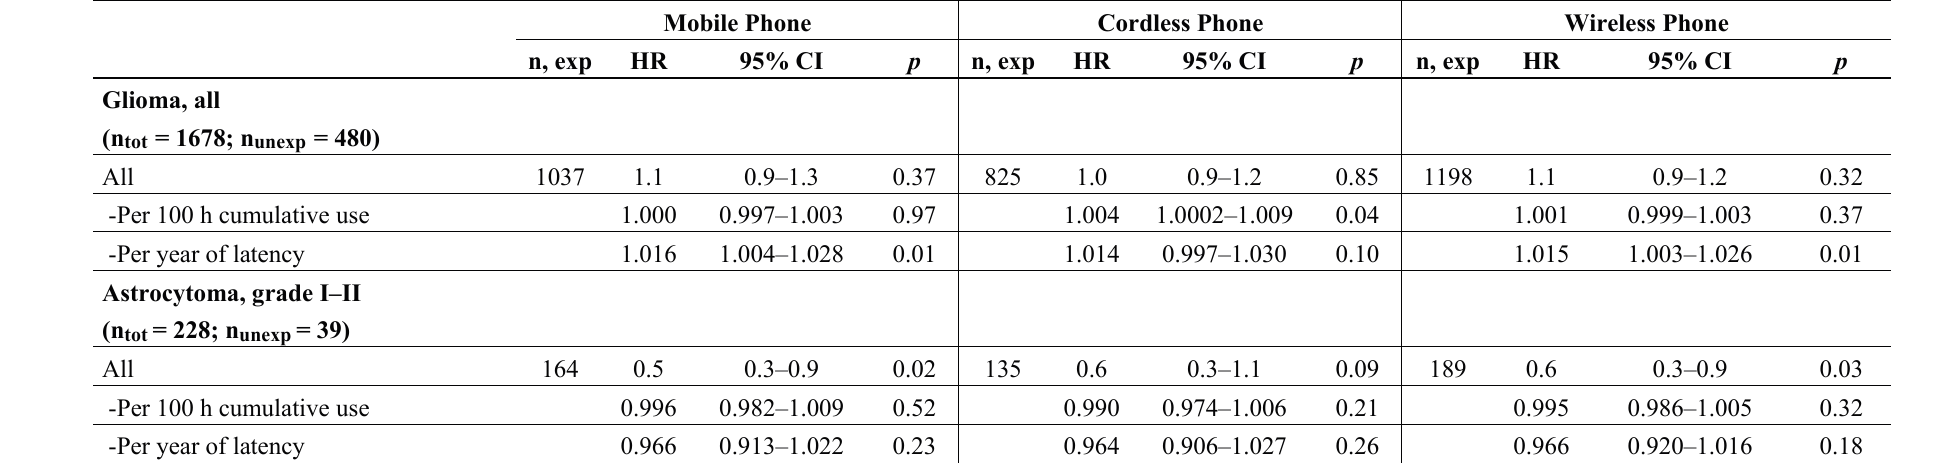
Table 2. Hazard ratio (HR) and 95% confidence interval (CI) from the Cox proportional hazards model for glioma and subtypes and use of mobile and cordless phones, overall results (ever use), per 100 h cumulative use, and per year of latency. Adjustment was made for age, gender, year of diagnosis, SEI-code, study, and age as a time-dependent